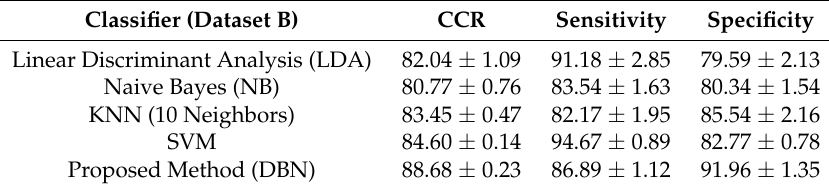
Table 8. Average value of correct classification rate, sensitivity and specificity ± standard deviation for Dataset